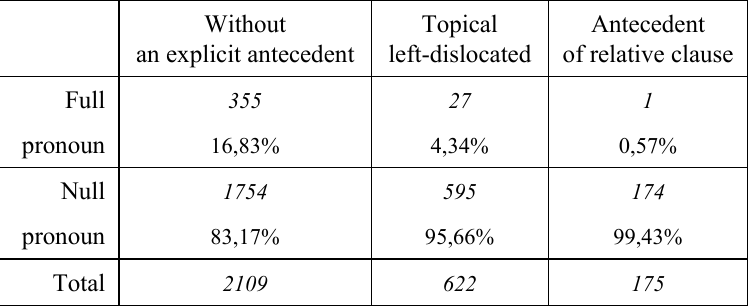
Table II: Pronominalization frequency: occurrence of an antecedent Without